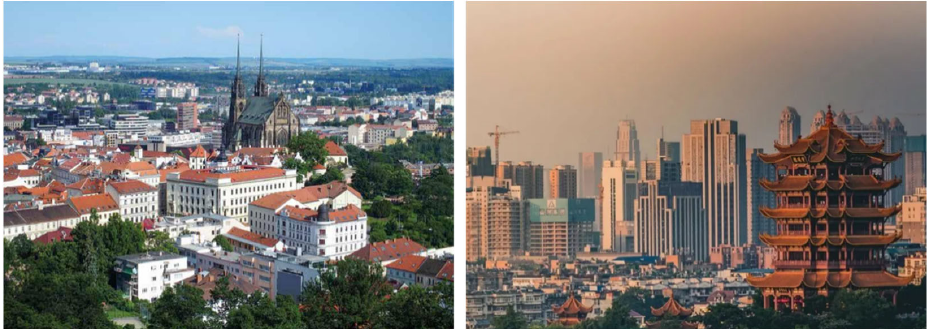
Figure 17. Historical and cultural heritage buildings in modern urban areas (Notre-Dame de Paris in France [3] and Yellow Crane Tower in China [38]).